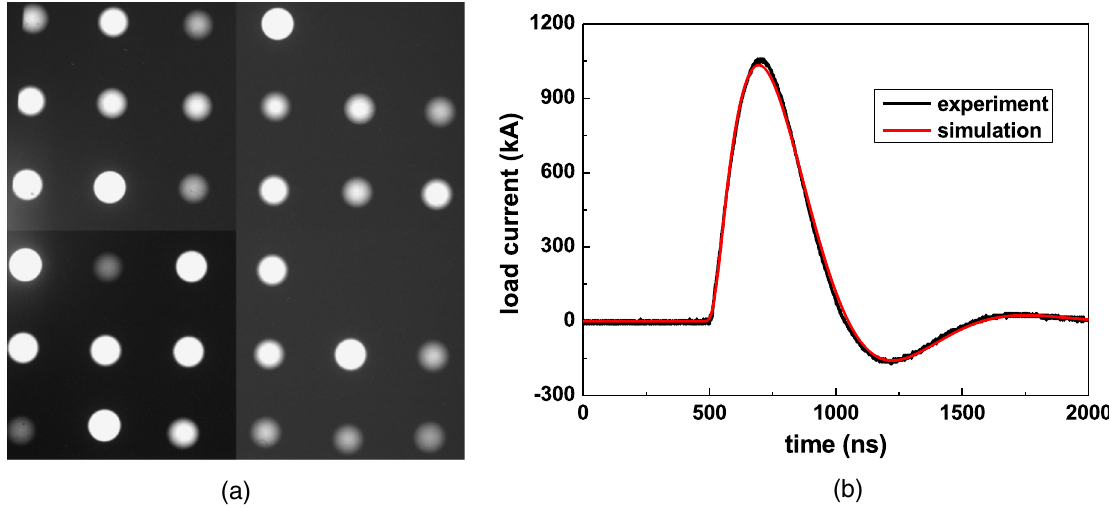
FIG. 16. (a) Image of 32 light spots recorded by CCD, which indicates all switches were closed. (b) Comparison of current pulses from experiment and from circuit simulation, indicating the performance meets